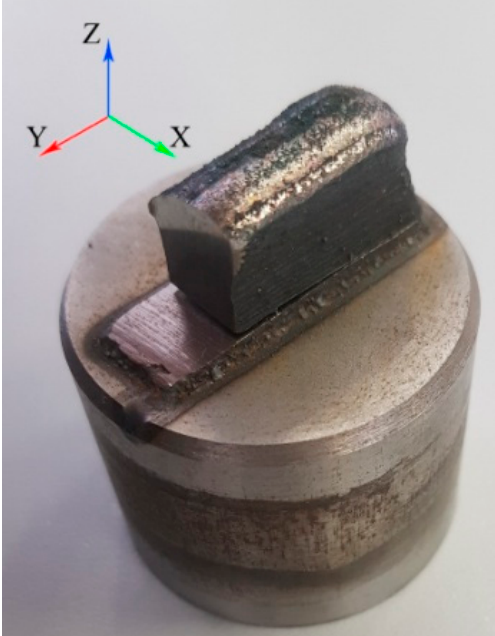
Figure 4. H13 steel (cross-section) made on the substrate with US-assisted L-DED. The microstructure of the original sample (without US) is shown in Figure 5, and the sample with US is shown in Figure 6. The study of the structure in the perpendicular di- rection was carried out over the entire cross-section of the sample, which makes it possible to characterize the entire structure of the sample, from the bottom of the surfacing to the top. In the longitudinal direction, the study of the structure took place at the base of the surfacing in the zone 1–2 mm above the substrate, where there is no longer any diffusion of elements from the substrate material. All of the obtained conclusions about the material in the parallel direction are valid for the material in this area, which also affects the area of interest for the cladding of functional coatings with a thickness of 1–2 mm.